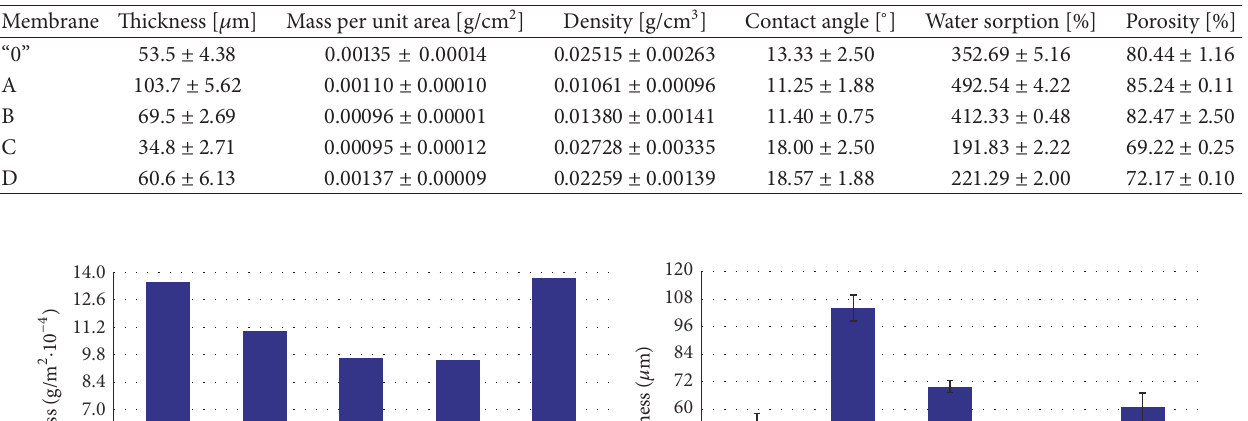
Table 1: Properties of the obtained membranes.